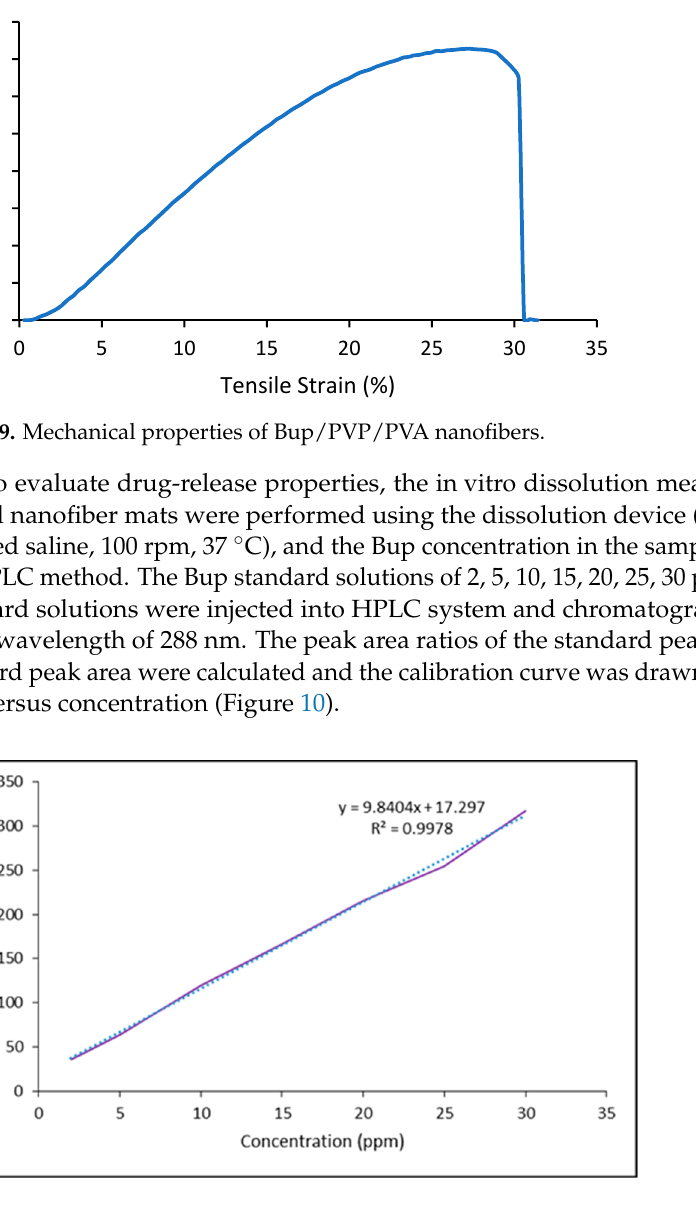
Figure 10. Calibration curve of Bup standard solutions in PBS.